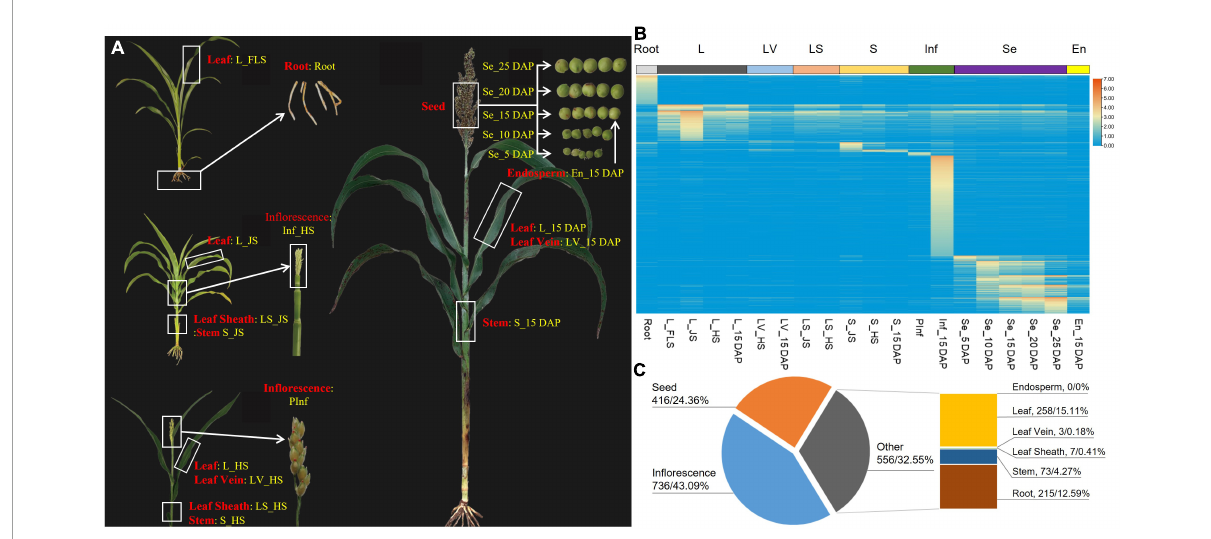
FIGURE1 Tissue-specific expression patterns of detected genes via RNA-seq. (A) Tissues (red) and samples (yellow) for RNA-seq. (B) Heat map of the tissue-specific genes. (C) Categories of tissue-specific highly expressed genes (number of genes and the corresponding percentage (%) were separated with/).